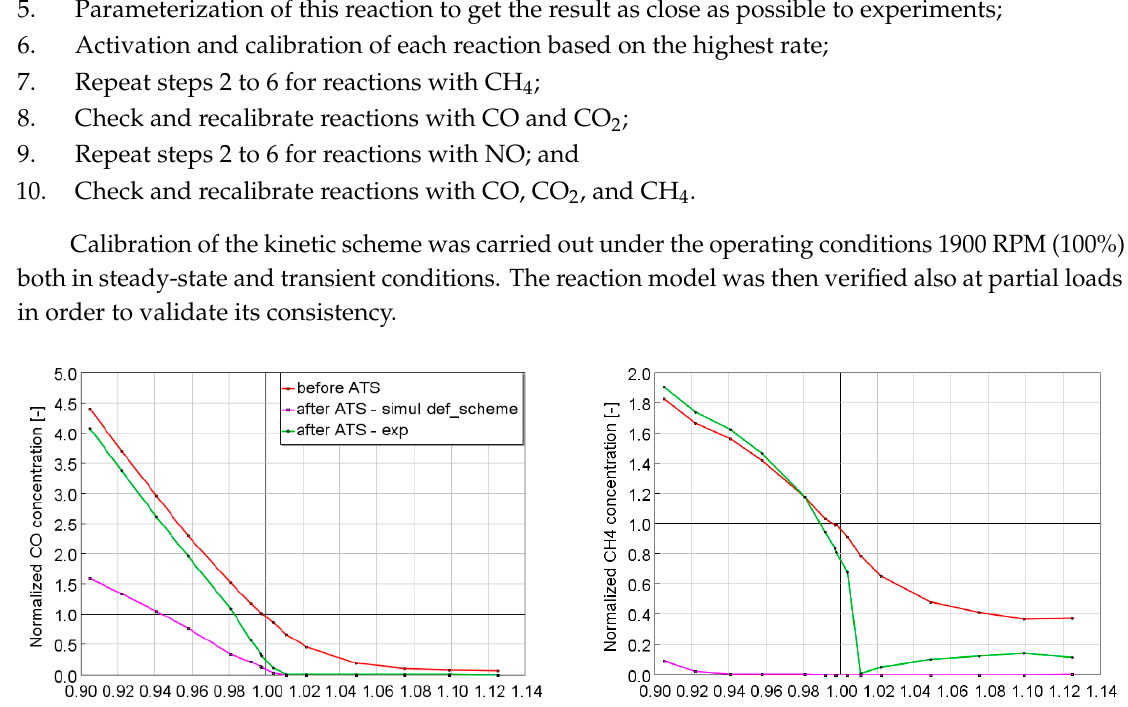
Figure 4. 𝐻 (cid:2870) /𝐶𝑂 ratio. Empirical correlation from Holder et al. [17]. It is clear that hydrogen measurements both at the inlet and outlet of the TWC would allow a better calibration for the nitrogen and carbon oxide conversions. In addition, measurements could also be interesting in evaluating possible interactions with NO in the direct production of NH 3 and N 2 O. It is worth to mention that the residual oxygen concentration in exhaust gases, especially in stoichiometric and in rich conditions, represents a critical issue. Indeed, its concentration, measured by the analyzer, was approximately equal to 0,2%, even in the conditions at the lowest AFR. As a